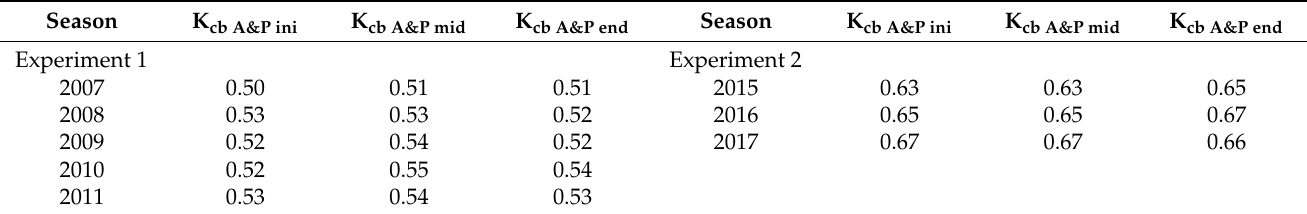
Table 9. K cb values estimated with the A&P approach.